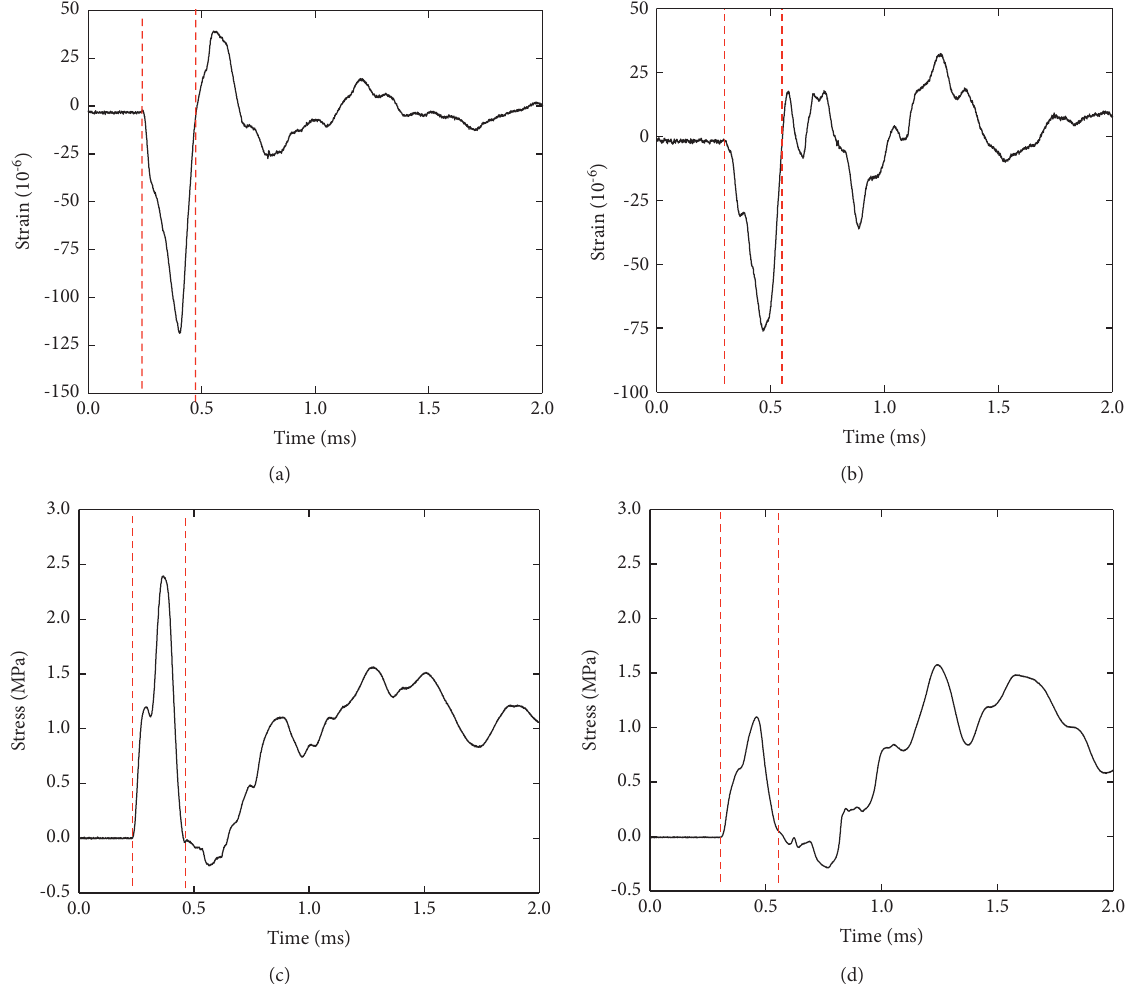
Figure 8: Typical incident and transmitted stress wave strain and stress time-history curves in intact rock. (a) Strain measuring point. (b) Strain measuring point 8. (c) Stress measuring point 15. (d) Stress measuring point 16.